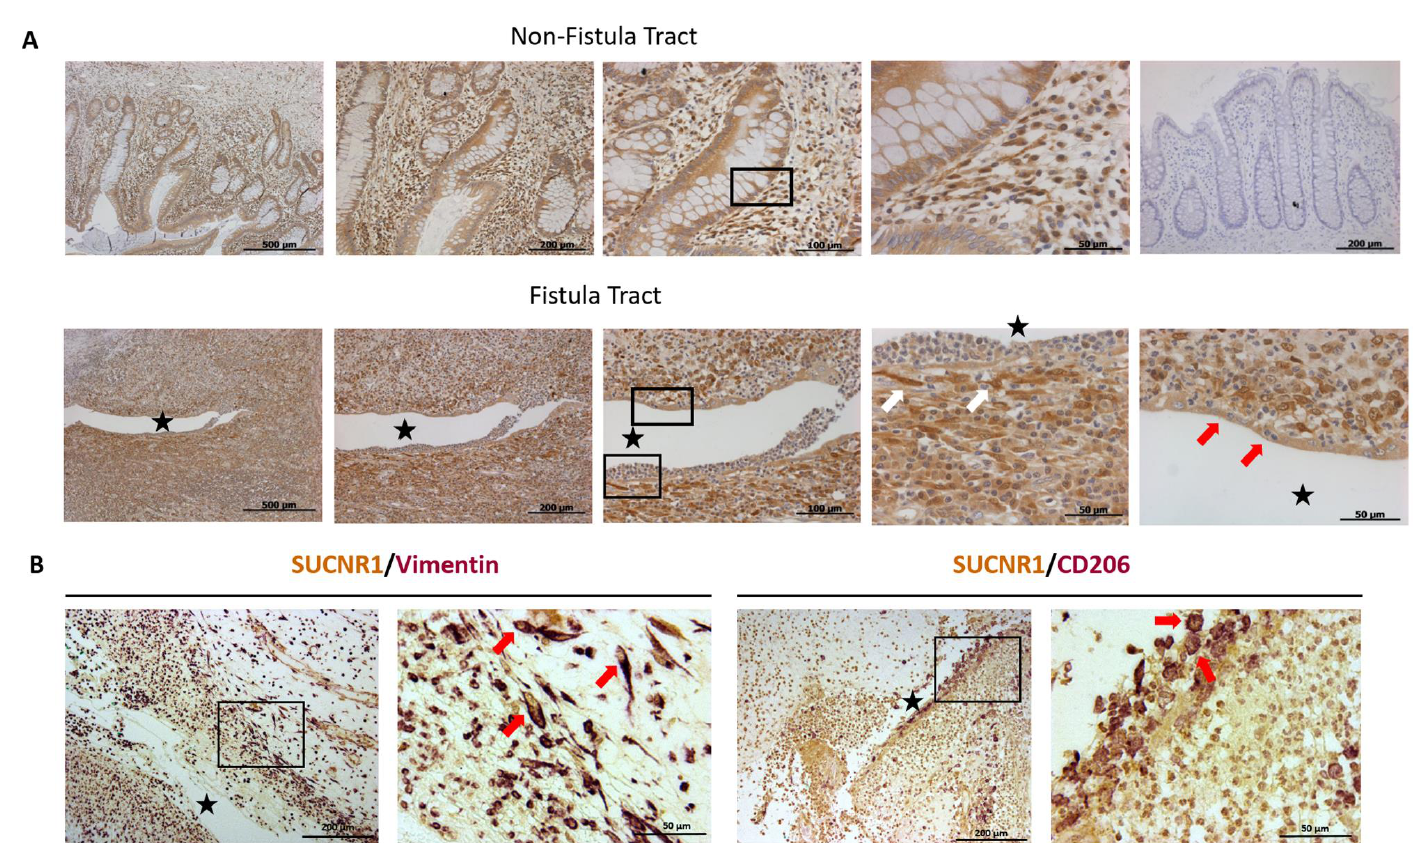
Figure 3. SUCNR1 is expressed in fibroblasts and macrophages of the fistula tract. ( A ) Immunostaining of SUCNR1 was performed in 5- µ m sections of para ffi n-embedded tissues, and representative pictures of areas without fistula (non-fistula tract) and areas including the tract of entero-enteric fistulas (fistula tract) from 5 B3-CD patients are shown. The black star indicates the fistula lumen. White arrows point to positive cells close to the fistula tract with a fibroblast morphology, and red arrows point to transitional cells (TCs). ( B ) Double immunohistochemistry of Vimentin-SUCNR1 and CD206-SUCNR1 was performed in 5- µ m sections of para ffi n-embedded tissues and representative pictures of areas including the fistula tract from 5 B3-CD patients are shown. Red arrows point to some cells double positive for SUCNR1 / Vimentin or for SUCNR1 /